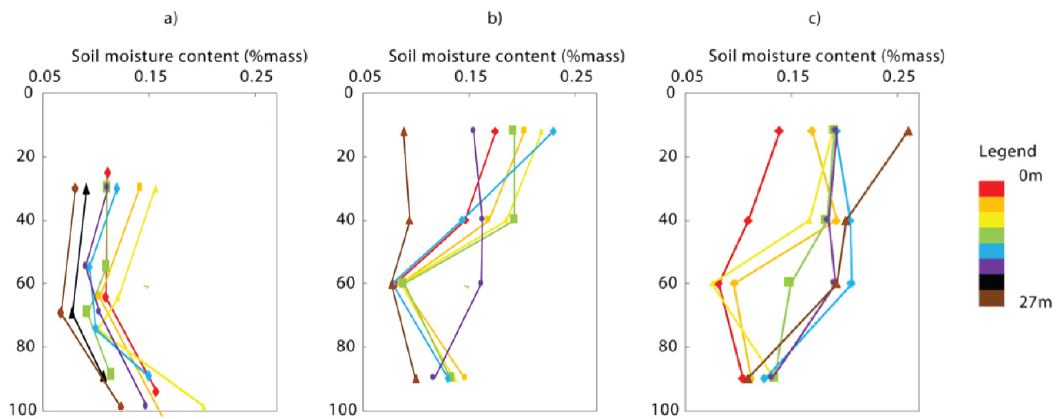
Figure 7. Individual soil moisture profiles taken on the ERT transect at different distances and at three dates: ( a ) at 14 October, ( b ) at 10 November, and ( c ) at 20 December. Figure 8 illustrates the correlation between measured gravimetric soil moisture and ERT measured resistivity, i.e., the closest pixel value, for a depth of 90 cm, as indicated by the dashed line in Figure 5, for the three dates and for all auger locations. To calculate the regression line and coe ffi